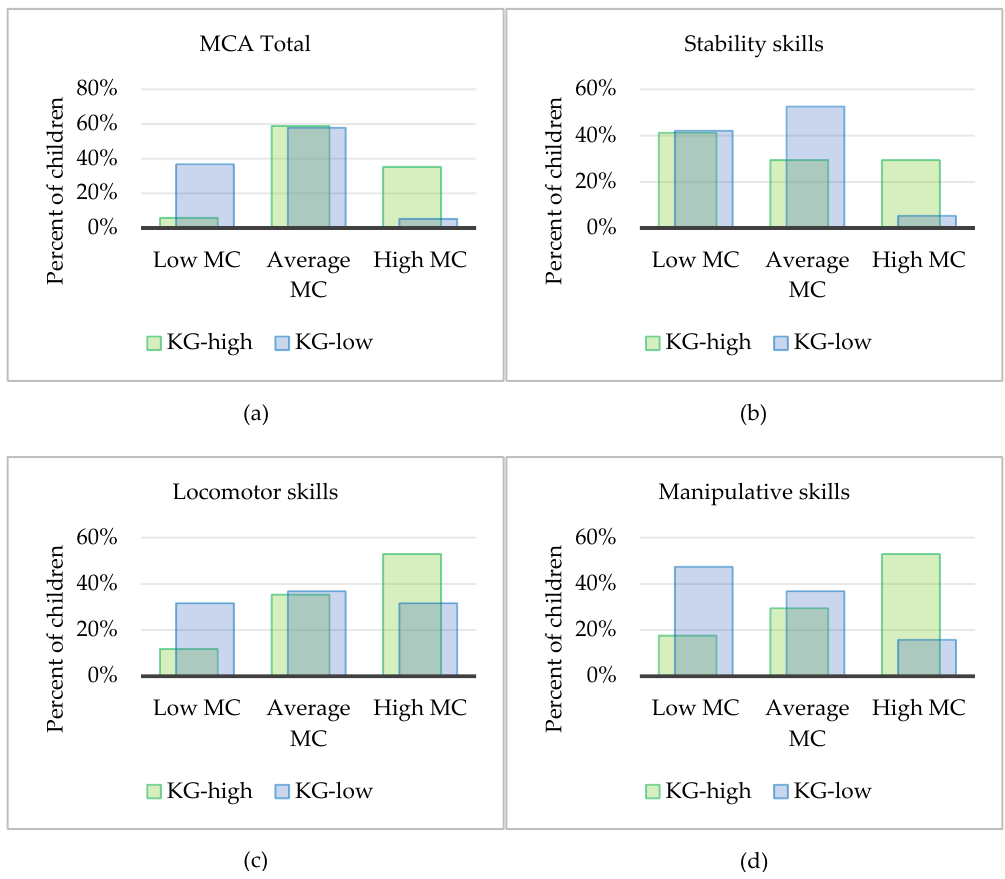
Figure 1. Percent of children from KG-high and KG-low by ( a ) Motor Competence Group for total, ( b ) stability, ( c ) locomotion, and ( d ) manipulative MCA. Table 3. Differences between KG-high (n = 17) and KG-low (n = 19) for children age, hours spent in kindergarten, hours in non-adult and adult led PA out of the kindergarten, and motor- and social – emotional competence outcomes.